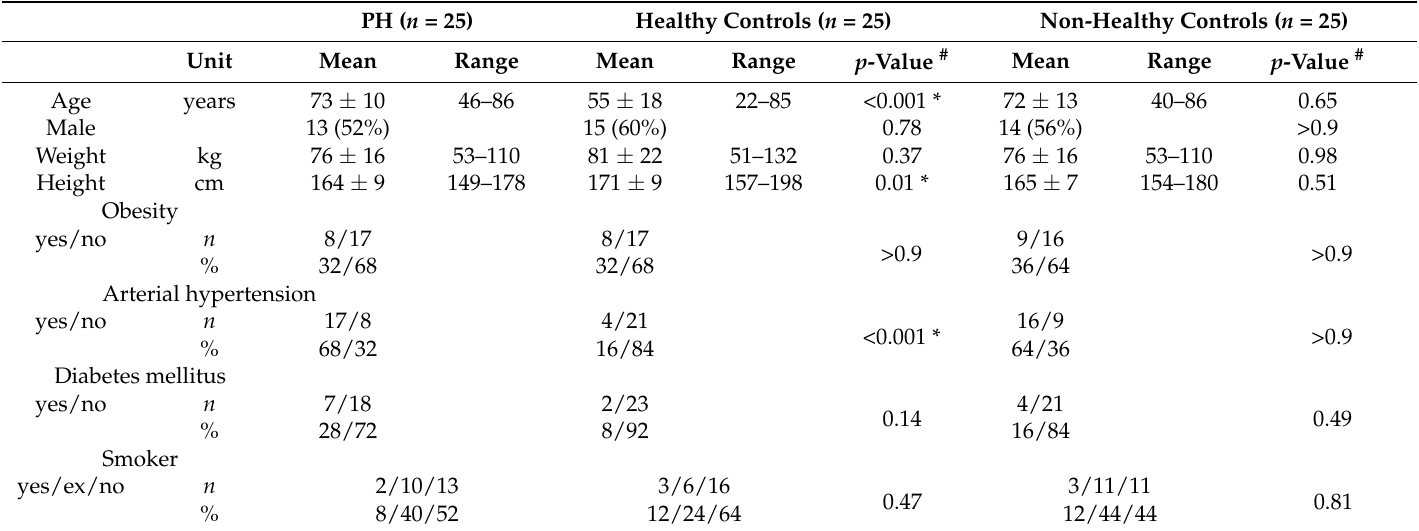
Table 1. Baseline